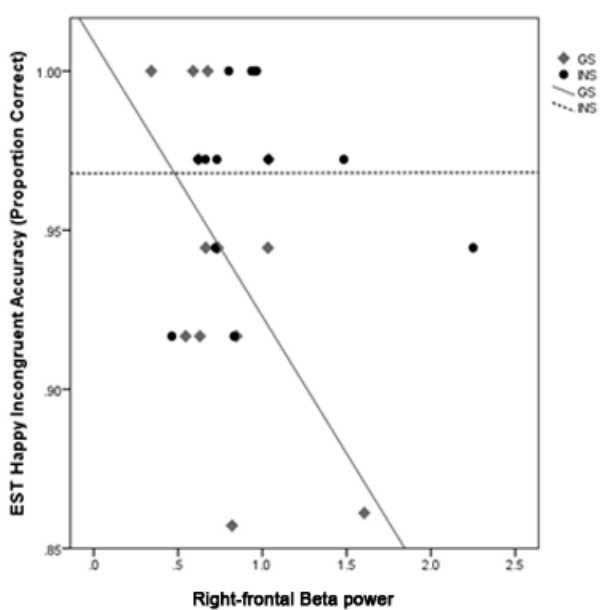
Figure 2. The correlations between right-frontal beta power and accuracy for Happy faces on the FCI for GS and INS groups. A night of greater right-frontal beta activity was associated with lower accuracy for the GS group.